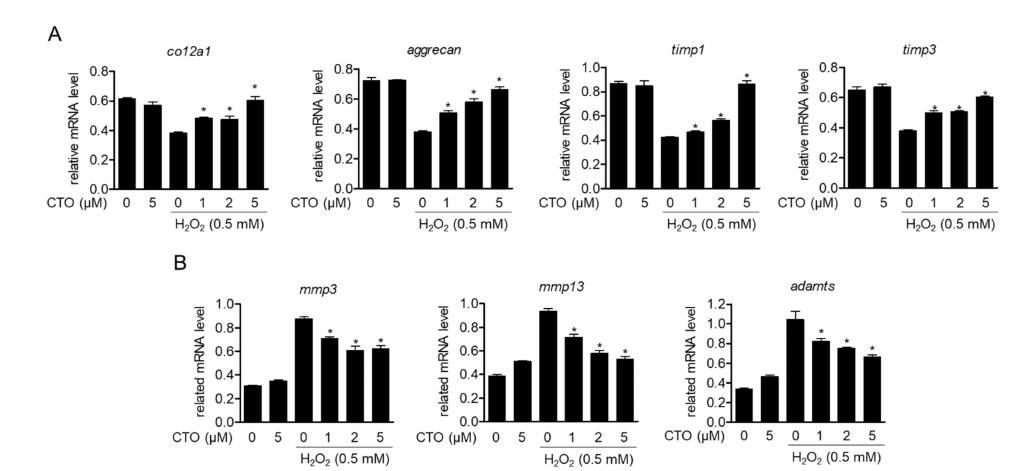
Figure 4. CTO up-regulates chondrocytes-specific genes but inhibits the expression of mmps in H 2 O 2 treated SW1353 cells. ( A , B ) SW1353 cells were pre-treated with the indicated concentration of CTO (0, 1, 2, and 5 µ M) for 6 h, and then incubated with 0.5 mM H 2 O 2 for 2 h. The mRNA levels of cartilage-specific core genes and timps ( A ) and mmps genes ( B ) were determined by real-time PCR analysis. The results were normalized to gapdh expression. * p < 0.05 was considered significant compared only to H 2 O 2 treat